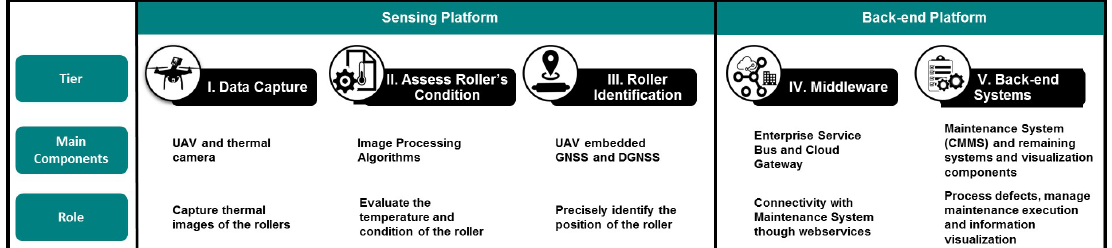
Figure 3. Main parts of the proposed solution to inspect conveyor belt